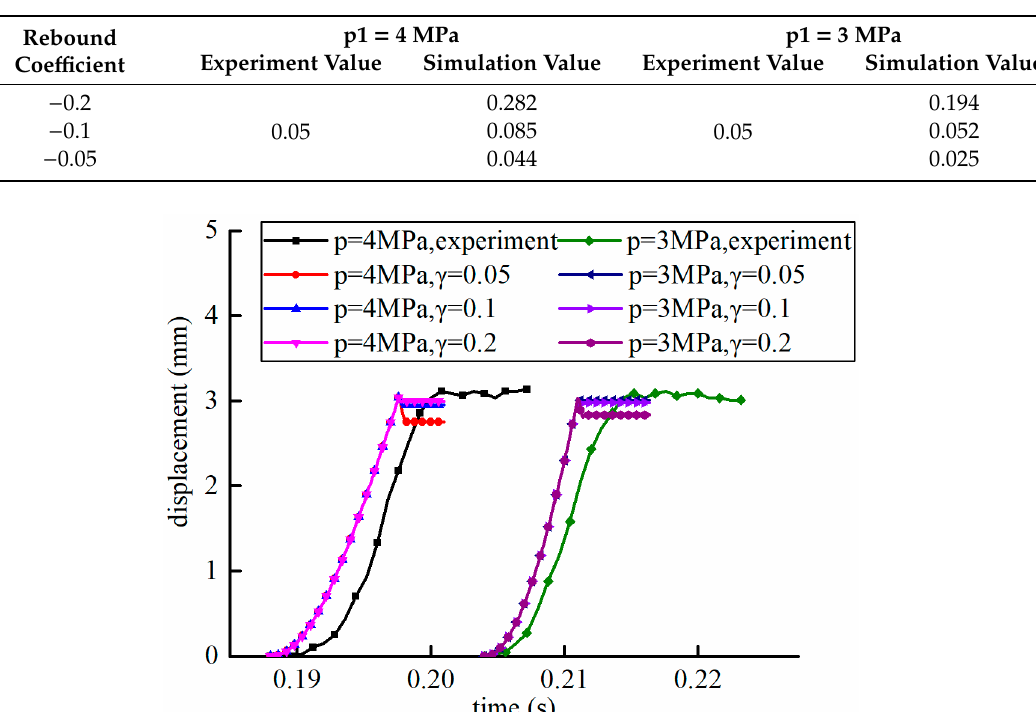
Table 3. The first bounce distance of different rebound coefficients.